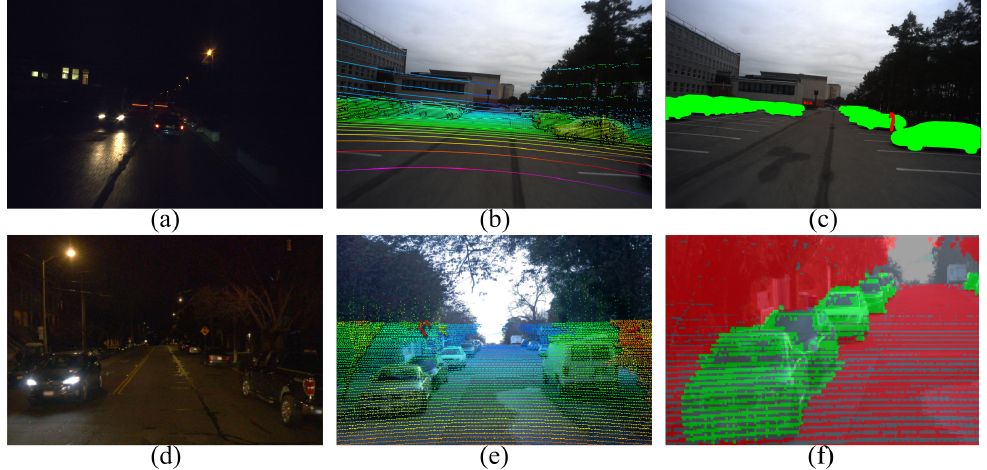
Figure 2. Extract from the iseAuto dataset ( a – c ) on the first row; the second row represents the Waymo dataset ( d – f ). For additional details, please refer to Section